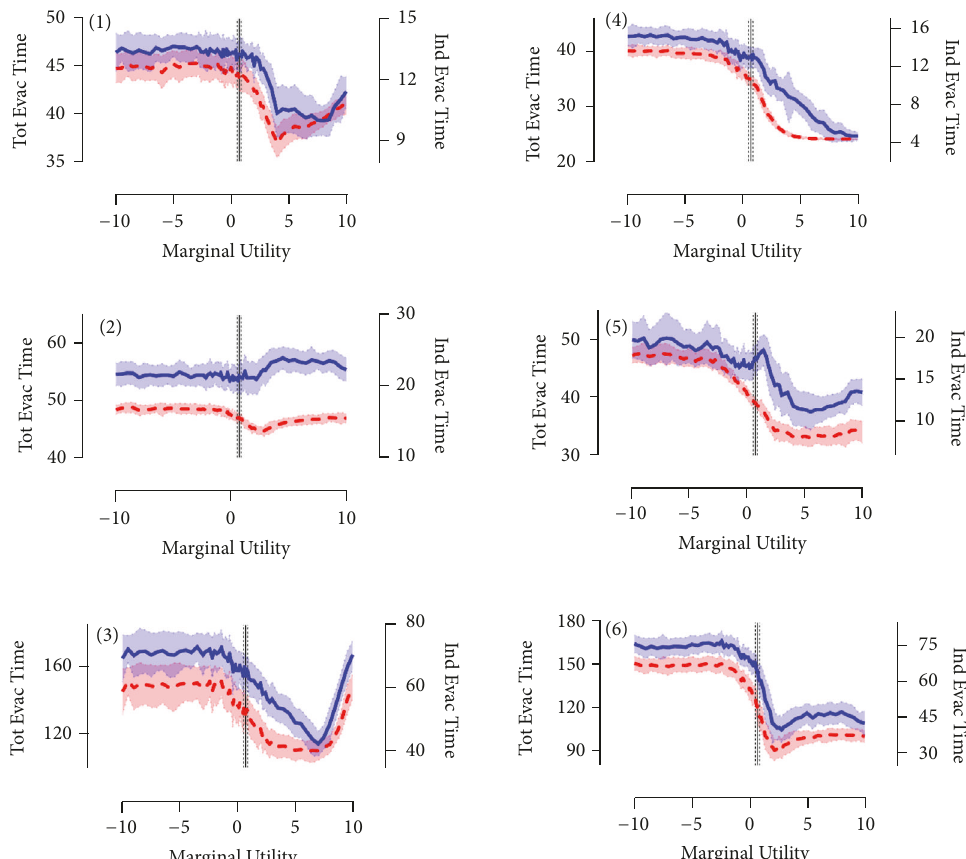
Figure 11: Variations of the simulated total evacuation times (blue solid lines; left vertical axis) and simulated average individual evacuation times (red dashed lines; right vertical axis) as a result of changes in the marginal utility of FLTOVIS attribute in exit decision-making of the simulated evacuees. Error bands show the standard deviations of the measurements. The vertical solid lines represent the empirically estimated value for the marginal utility of FLTOVIS, and the vertical dashed lines visualise the 95% confidence interval of that